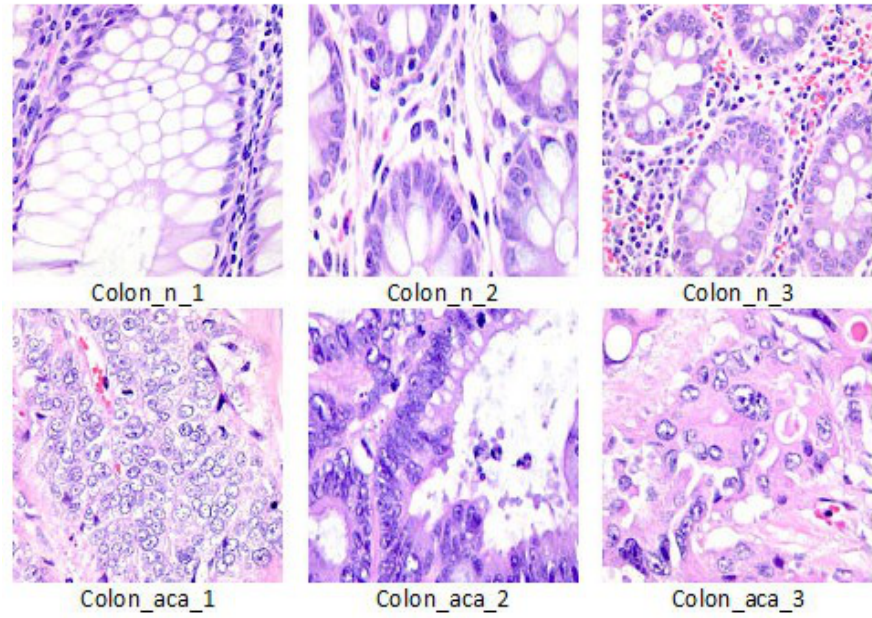
Figure 1. Visual examples of nine histopathological images from the used dataset (where colon_n refers to normal image and colon_aca refers to an image with colon cancer).